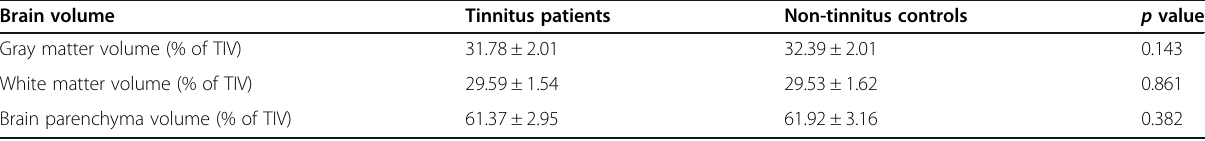
Table 3 Comparisons of volumes between tinnitus patients and non-tinnitus controls Brain